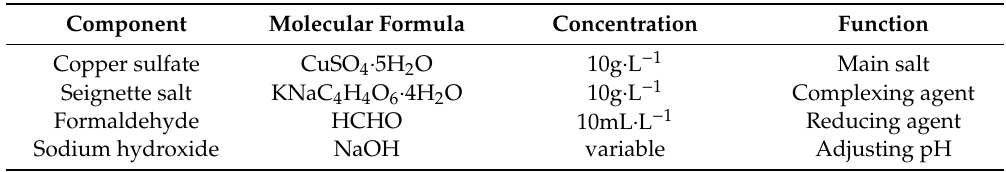
Table 2. Key components and their concentrations for electroless copper plating